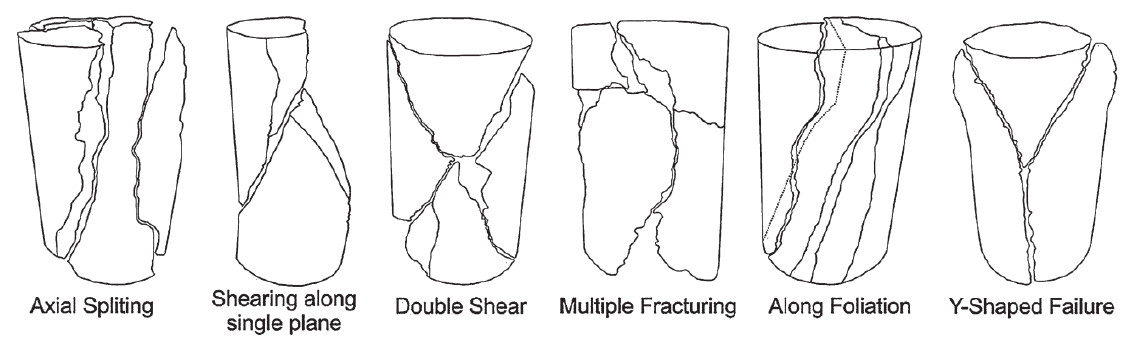
Figure 7: Schematic representation of different possible failure patterns of the sample under uniaxial compression extracted and proposed by Basu et al. (2013).